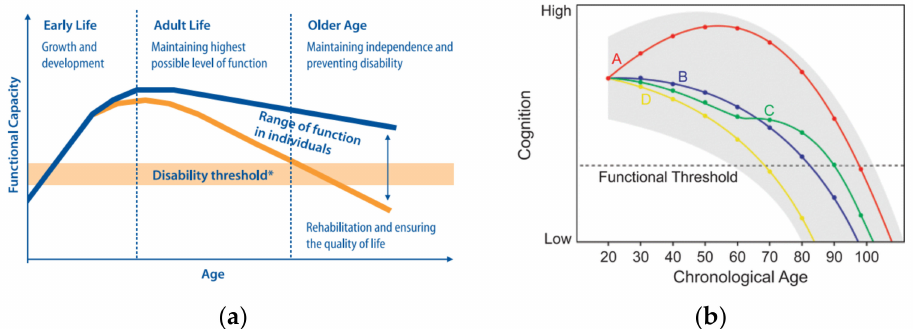
Figure 3. ( a ) WHO (2002) proposal about aging and functional capacities across a life cycle [56]. Reproduced with permission from WHO, Active ageing: a policy framework, Page 14;published by WHO, 2002., Copyright 2020; and ( b ) Hertzog et al.’s [57] proposal about growth and decline across a life cycle. Reproduced with permission from SAGE Publications. License